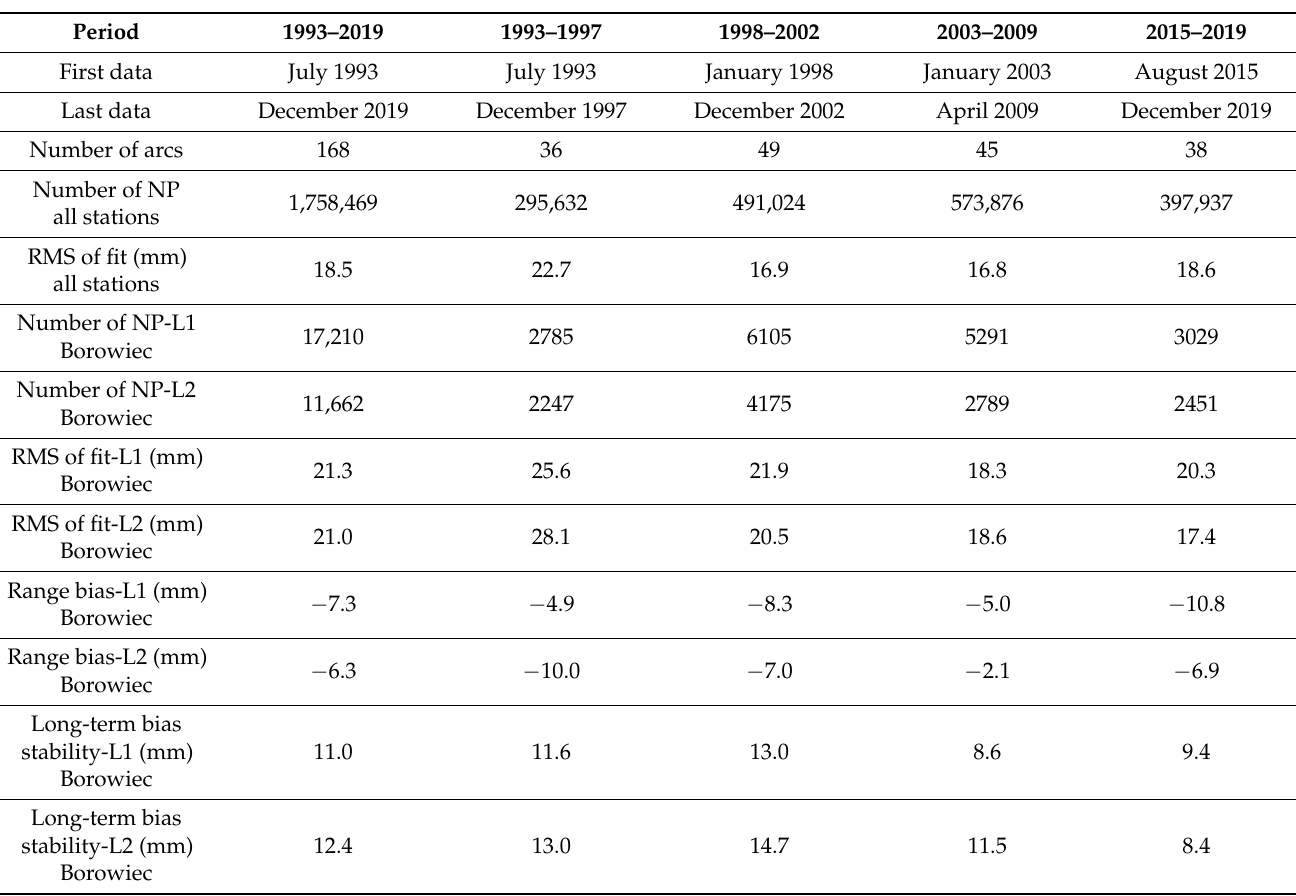
Table 4. The results of the orbital analysis of the Borowiec SLR station (7811) data for LAGEOS-1 (L1) and LAGEOS-2 (L2) in